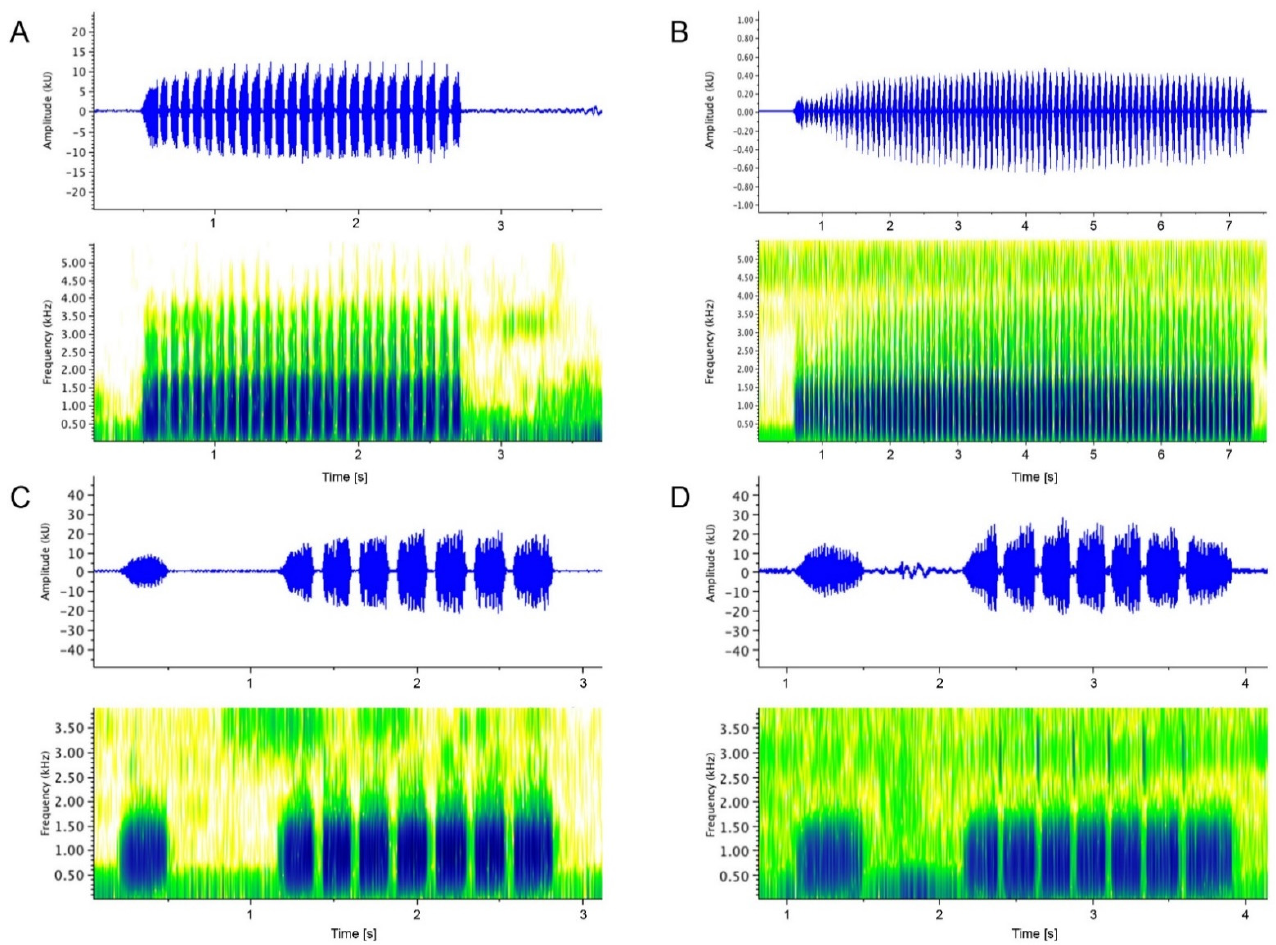
Figure 4. Advertisement calls of male Limnonectes . ( A ) L. doriae , SMF 104084 (Mon State, Myanmar); ( B ) L. doriae , ZMKU 1552 (Mae Hong Son Province, Thailand); ( C ) L. bagoensis n. sp., SMF 104090 (Bago, Bago Region, Myanmar); ( D ) L. bagoensis n. sp., SMF 106039 (Bagoyoma, Bago Region, Myanmar). See text for details and Figure 4 for localities plotted on map.